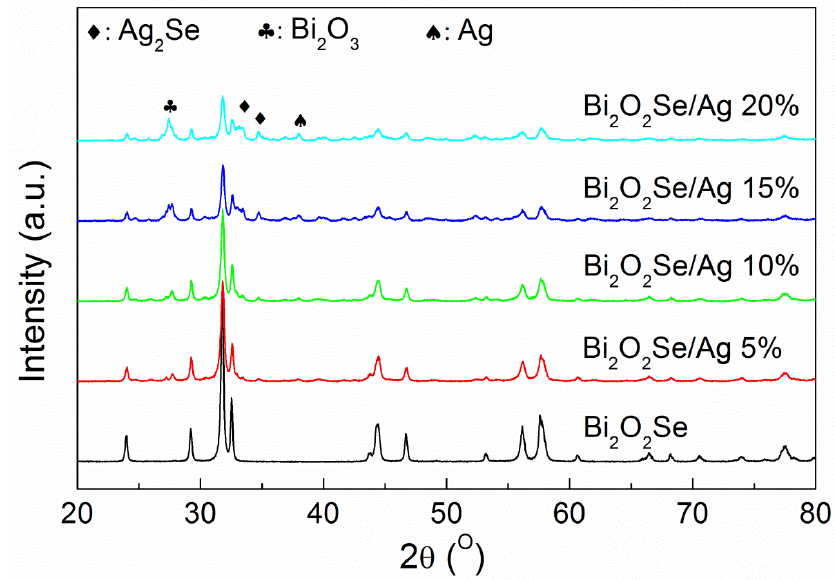
Figure 1. Room temperature X-ray diffraction patterns of Bi 2 O 2 Se/Ag